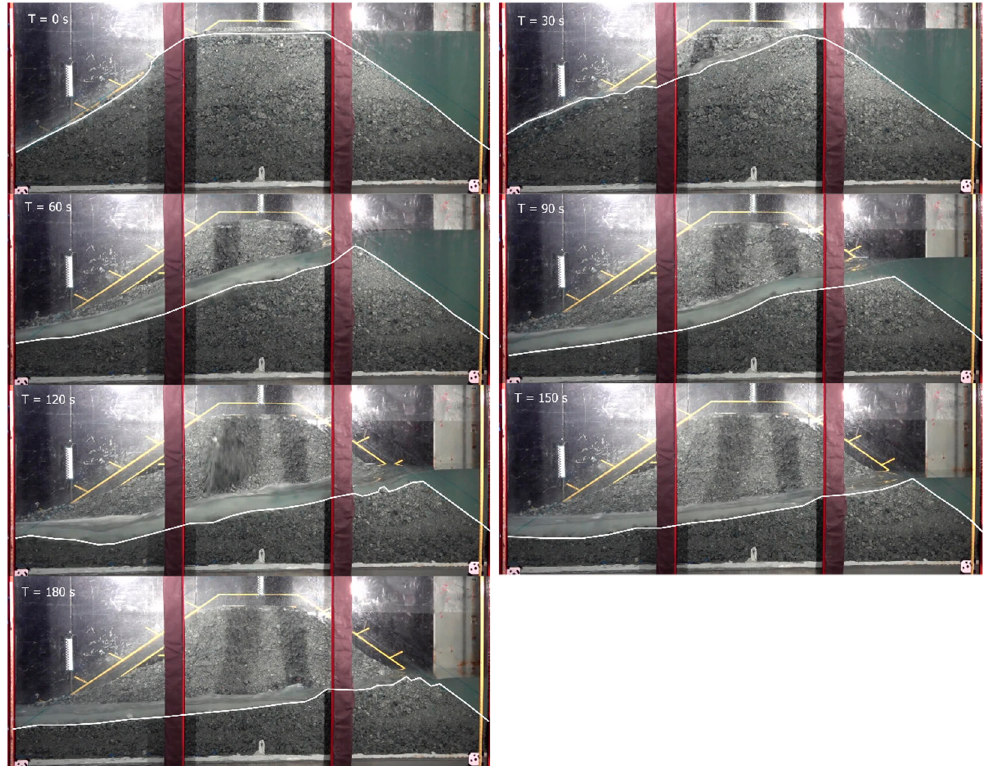
Figure 9. Side-view tracking of breach progression of model H1 (no core); direction of flow is right to left ; white line indicates traced solid surface.